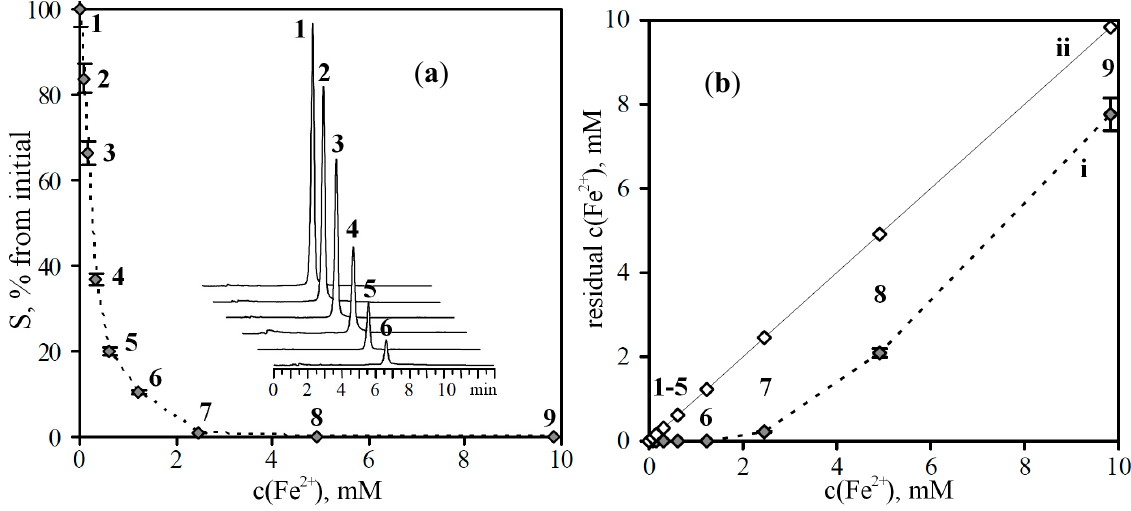
Figure 1. ( a ) Reduction of peak areas (S) of baicalein after prechromatographic reaction with different concentration of Fe 2+ ions. On cut—chromatograms of baicalein samples before ( 1 ) and after prechromatographic reaction with Fe 2+ ions ( 2 – 6 ). ( b ) Residual concentration of Fe 2+ ions after reaction of baicalein with Fe 2+ ions versus initial concentration of Fe 2+ ions ( i ). On ii —hypothetical curve in case of absence of chelation